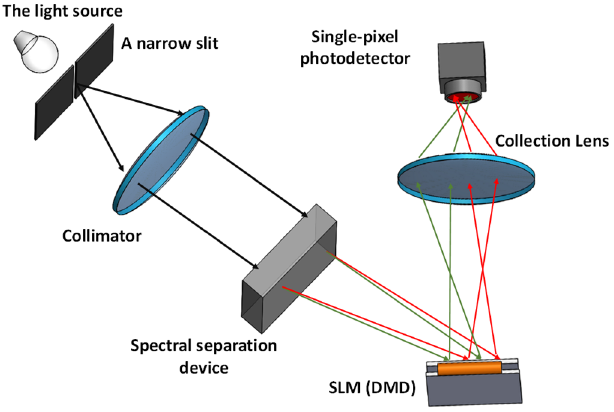
Figure 12. A typical architecture for building a spectrometer using DMD.